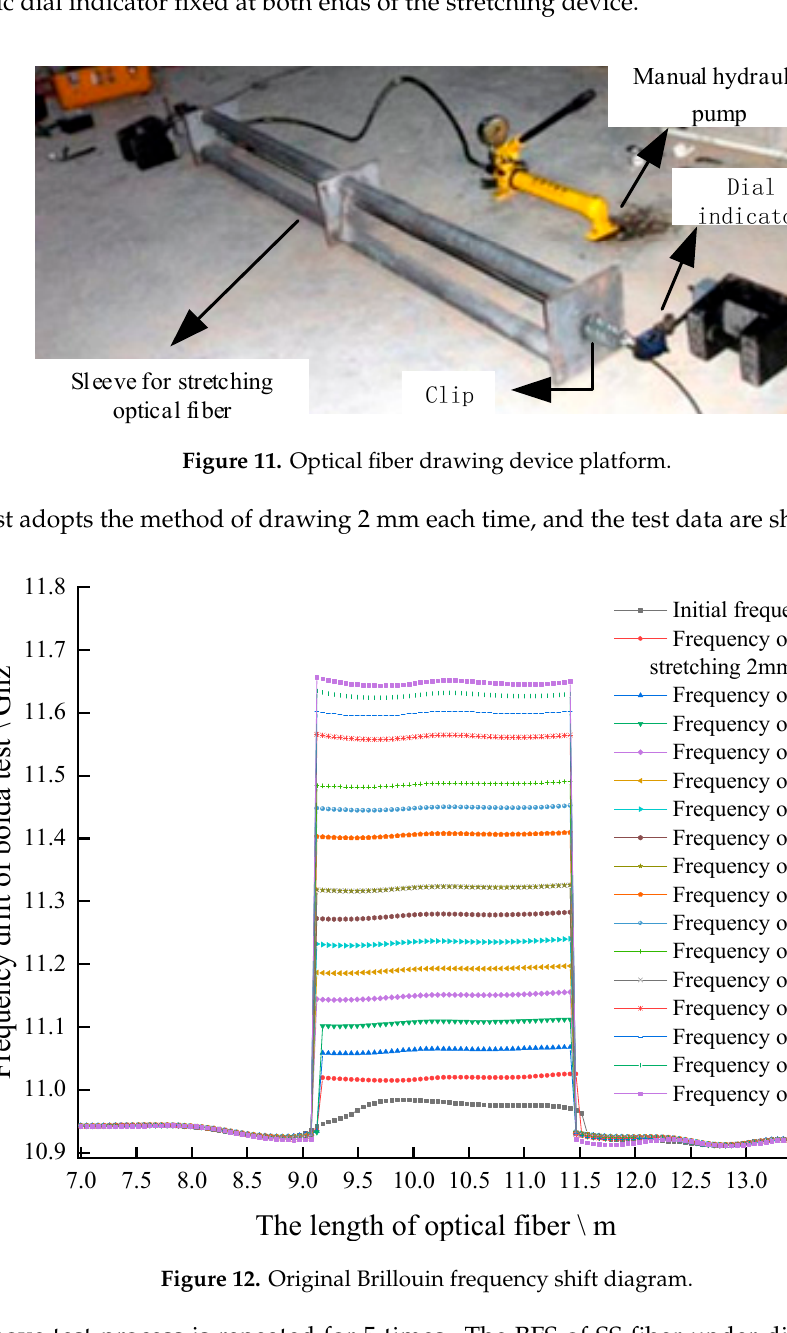
Figure 12. Original Brillouin frequency shift diagram.